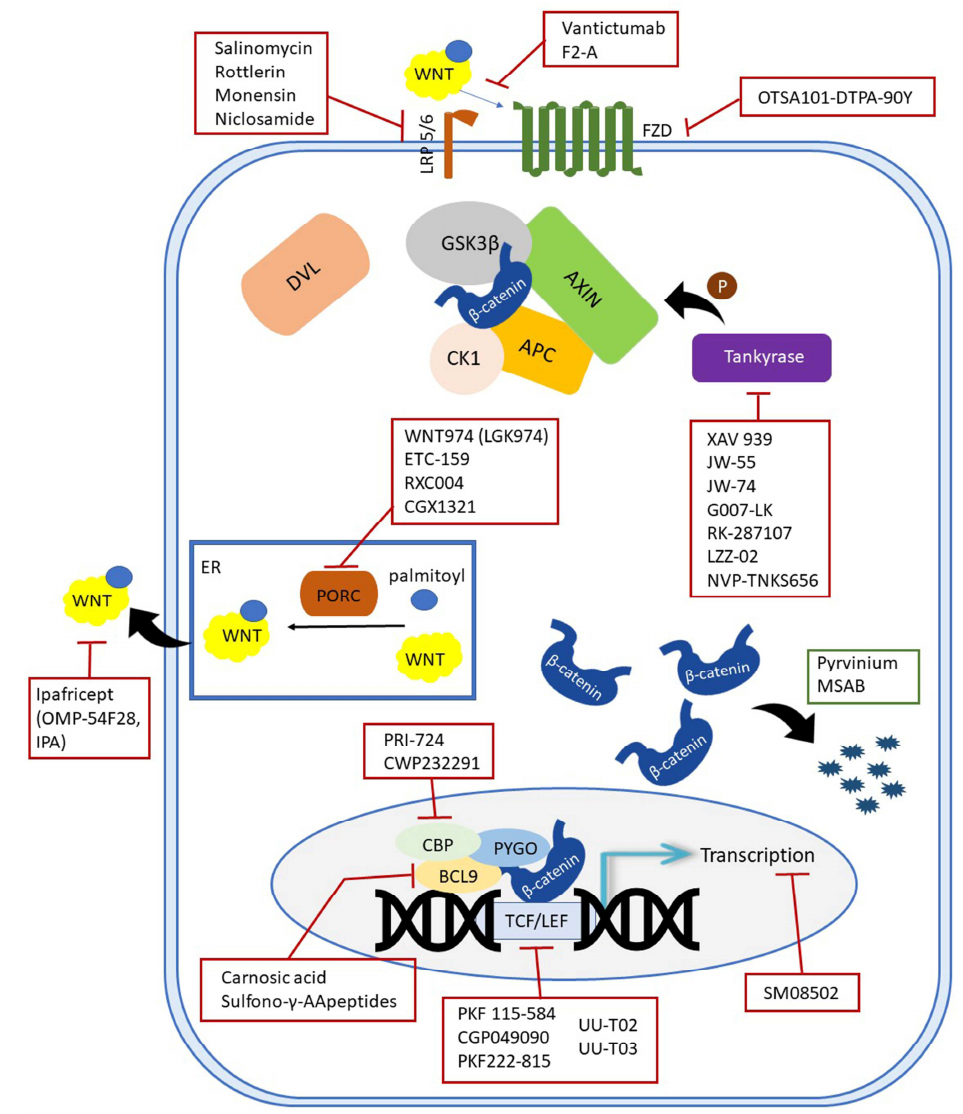
Figure 2. Schematic representation of inhibitors targeting the canonical Wnt